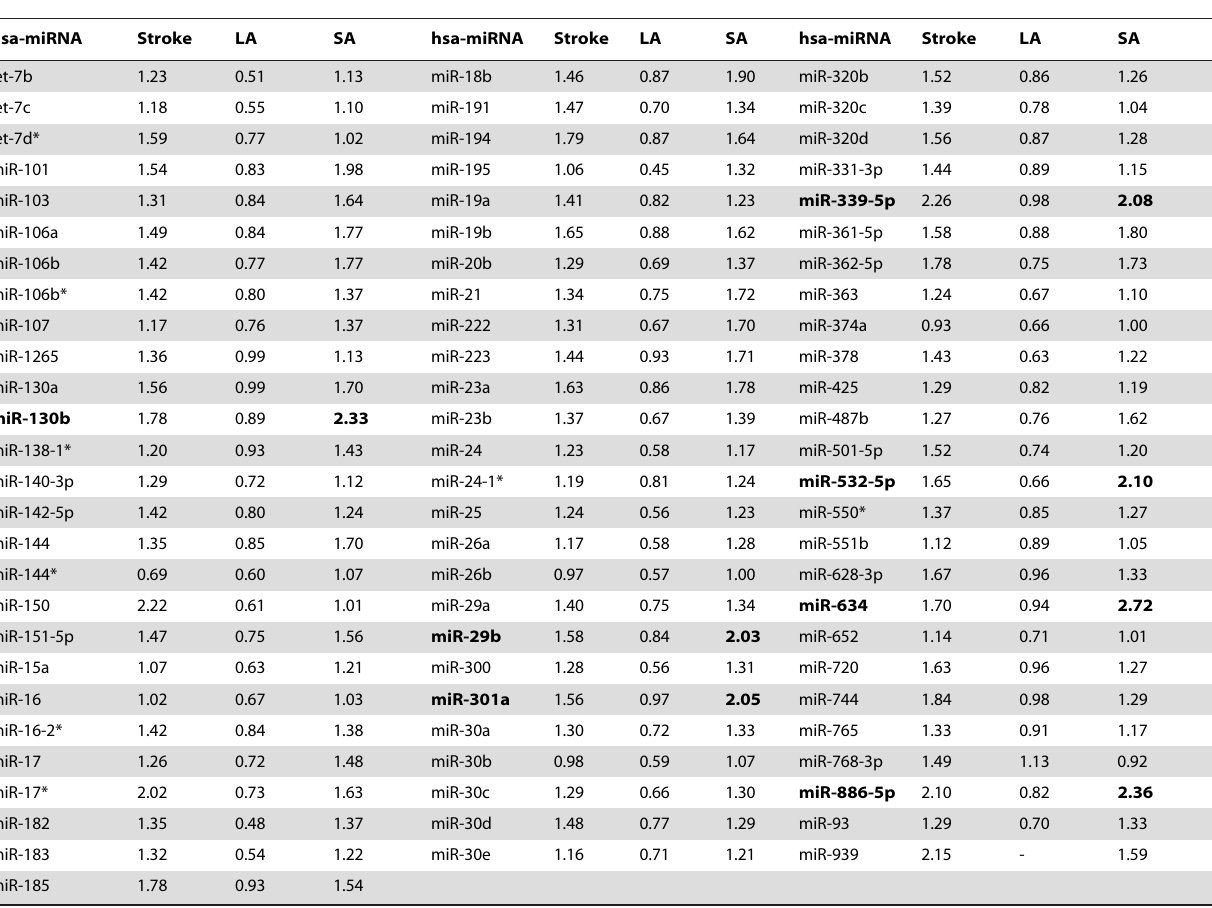
Table 3. miRNA expression pattern in large artery (LA) and small artery (SA) stroke.